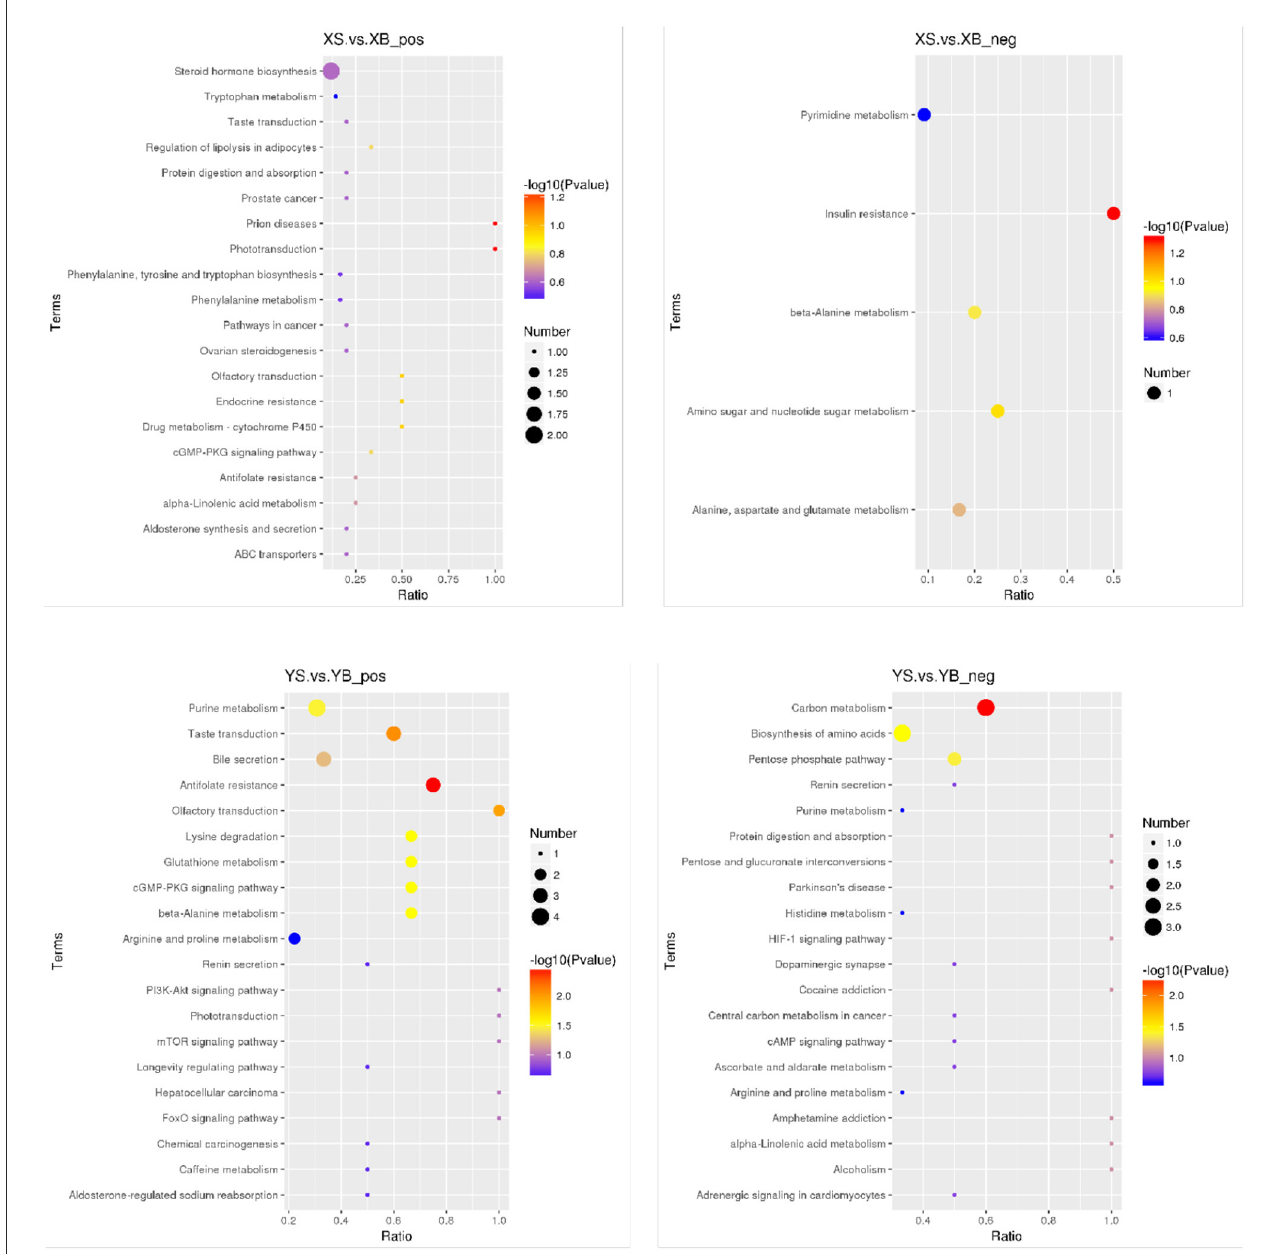
FIGURE5 Bubble plot of KEGG enrichment in rumen fluid (positive and negative ion mode). The spot color represents the p -value in hypergeometric test, the size of the spot correlates with the number of the different metabolites in the